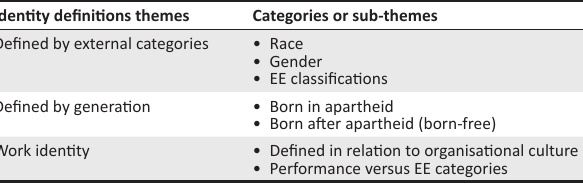
TABLE 2: Identity definition